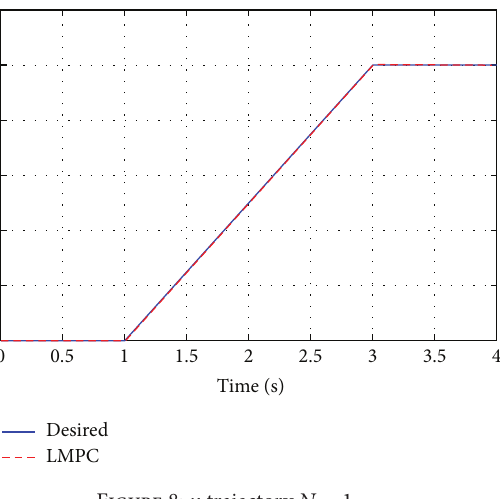
Figure 8: 𝑥 trajectory 𝑁 = 1 .